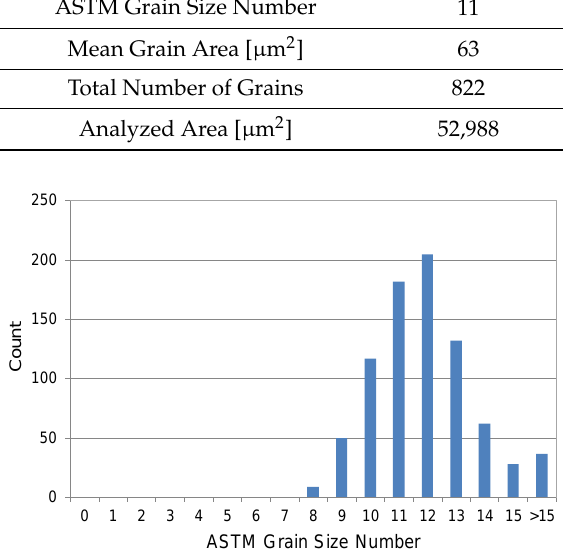
Figure 2. Titanium Grade 2 grain size distribution according to the ASTM standard.